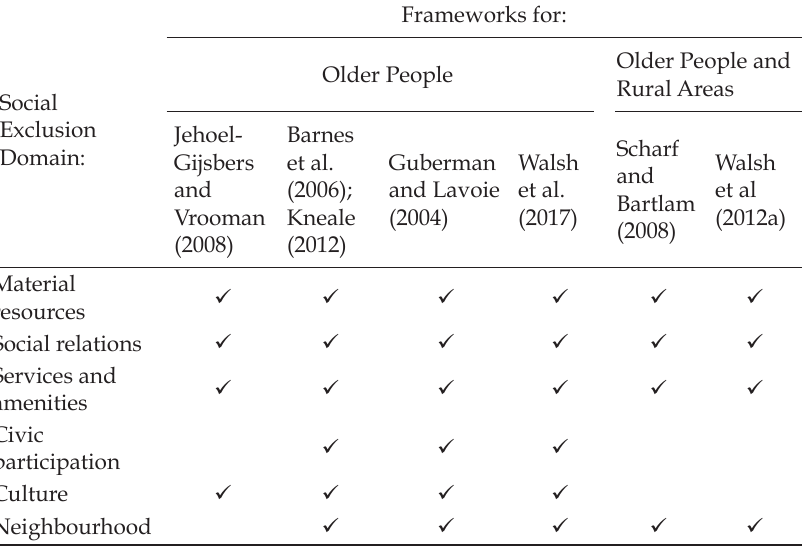
Table 1. Conceptual frameworks and the domains of social